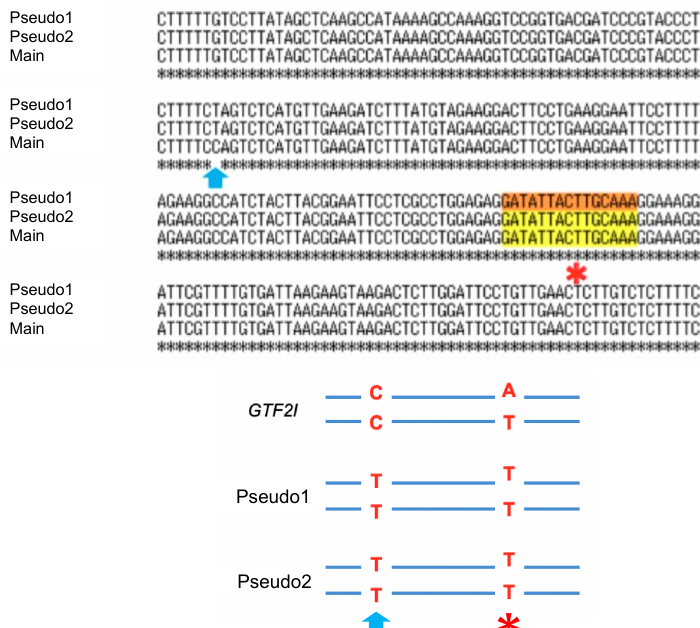
Figure 3. Sequence alignment of GTF2I (main) and its pseudogenes showing the single nucleotide variation (as indicated by the arrow) upstream of the point mutation (*). The substitution mutation (* mutation site, thymine (T) > adenine (A)) on the true GTF2I DNA strand with cytosine pointed by the arrow was categorized as the true